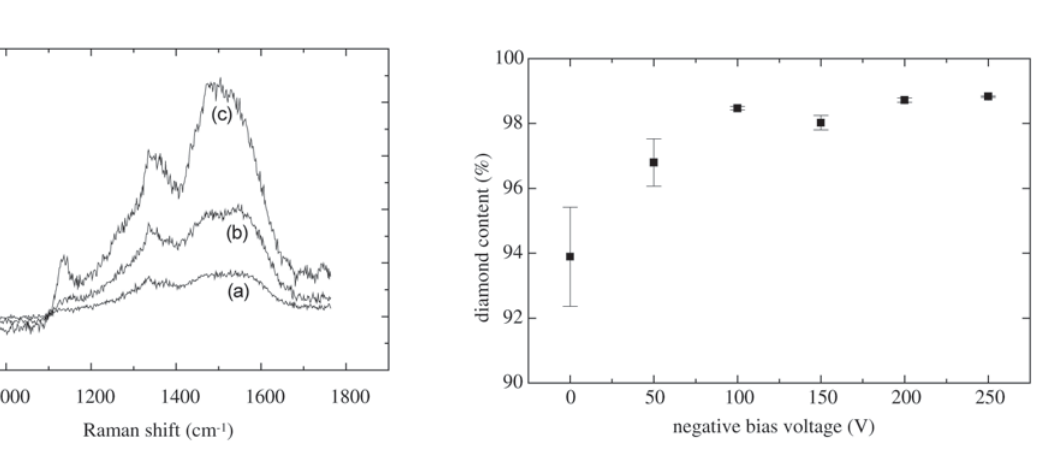
Figure 5. Amount of diamond relative to graphite as function of bias